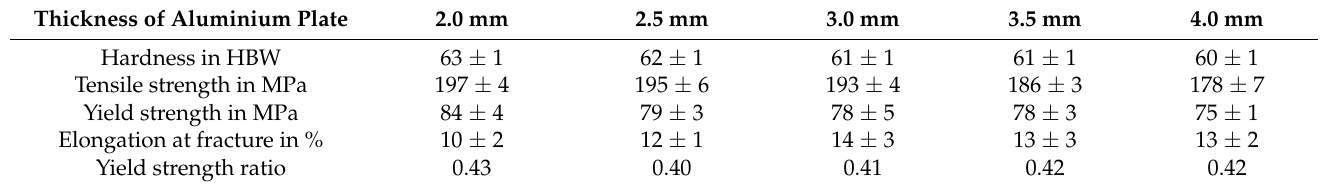
Table 4. Measured mechanical properties of the aluminium casting alloy in the various plate thicknesses. Thickness of Aluminium